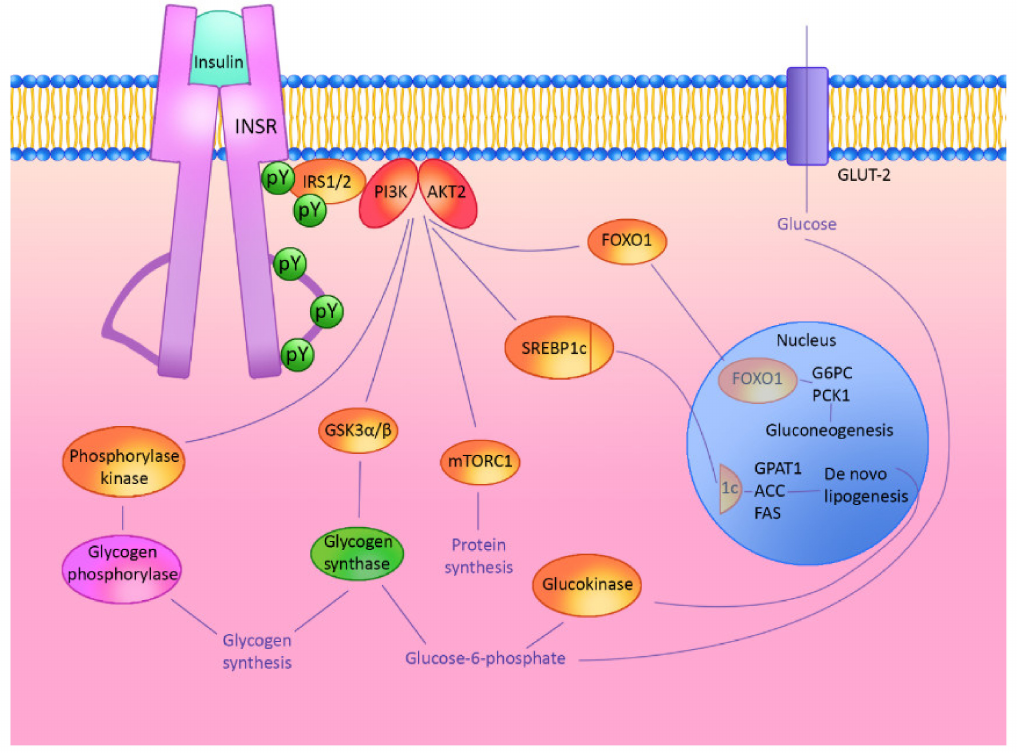
Figure 1. Hepatic insulin signaling